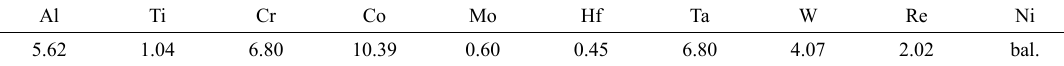
Table 1. Chemical composition of the CMSX-4 specimens in wt.-% as determined using EDS (Quantax, Bruker Corp.)